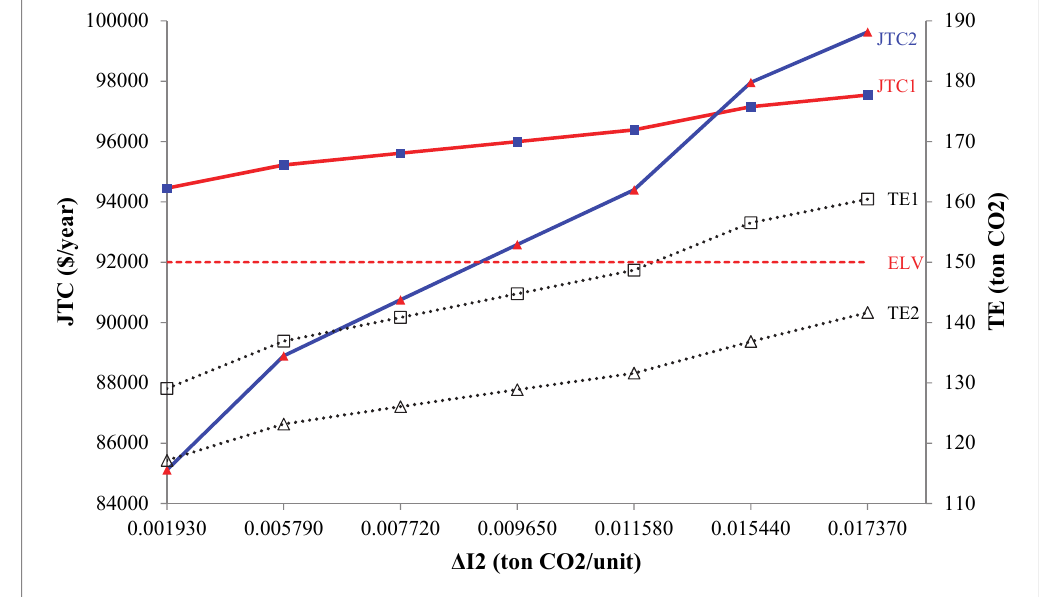
Fig. 18. Effect of changing in industrial direct emission factor on total cost and total